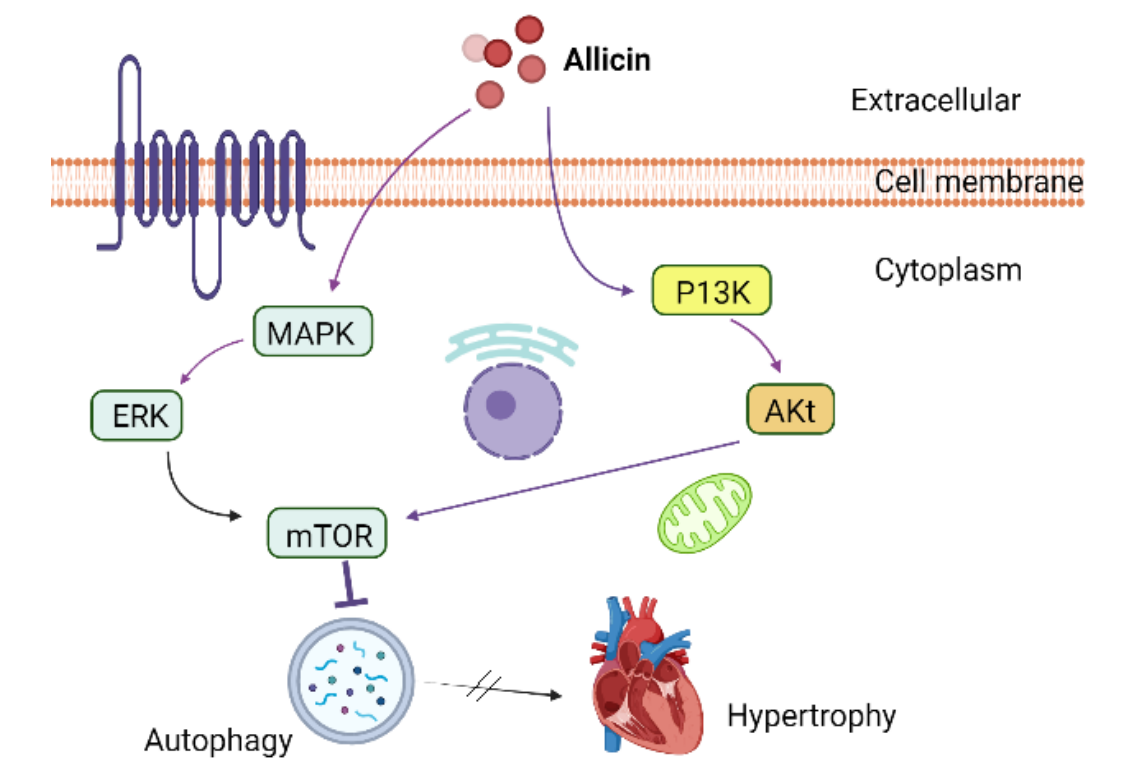
Figure 6. Allicin attenuated cardiac hypertrophy by regulation of autophagy via mTOR regulatory pathways.